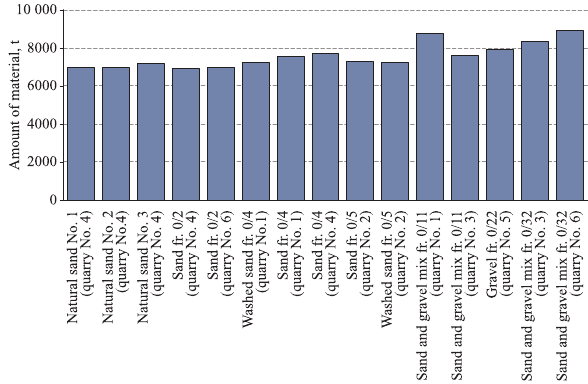
Fig. 4. The need for different materials to lay a 1 km long, 42 cm thick frost blanket course on the road of category III